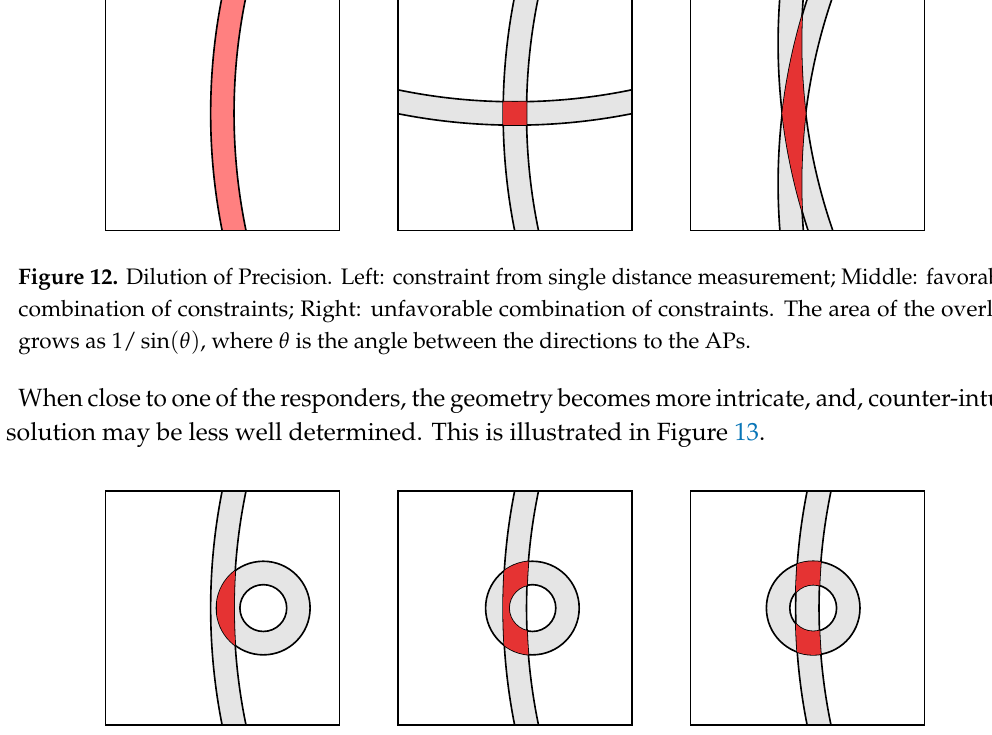
Figure 13. Dilution of Precision when close to responder. Left: Intersection is more or less an oblong oval; Middle: Intersection is approximately kidney shaped; Right: Intersection is bimodal. Such distributions cannot reasonably be approximated by multi-variate